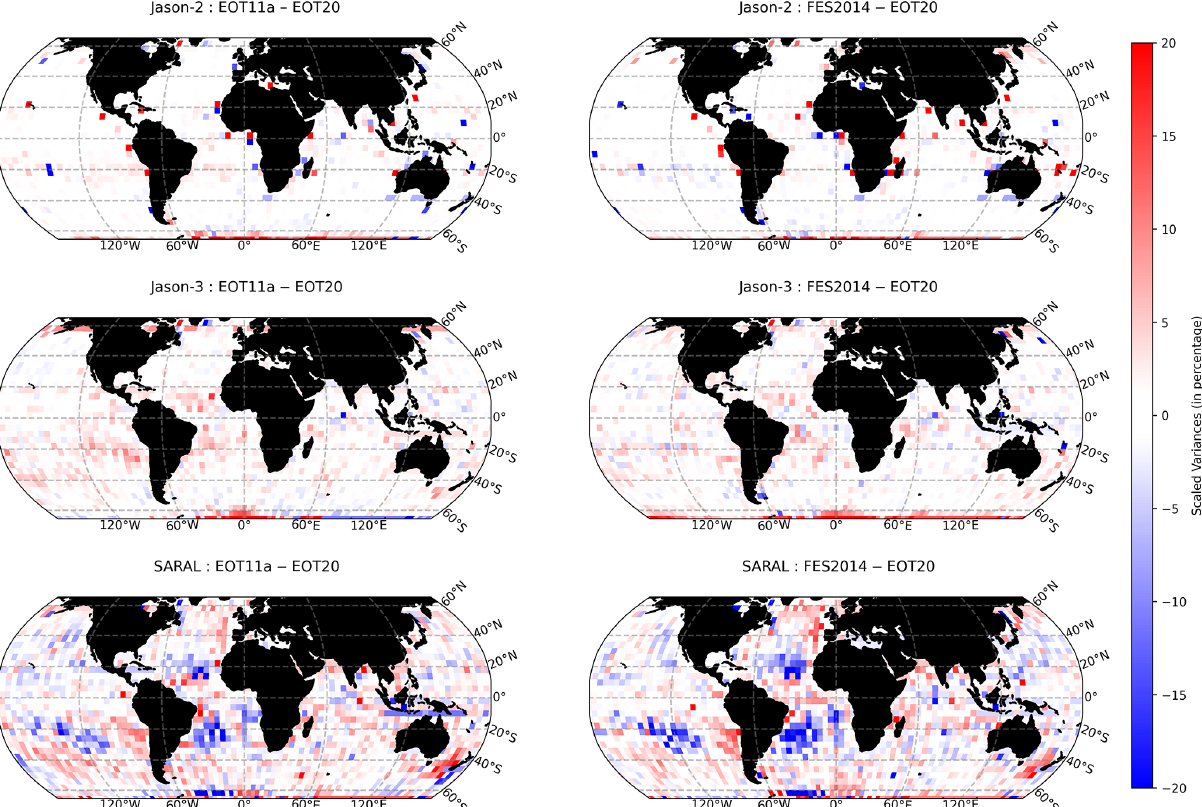
Figure 6. The global scaled SLA variances differences for Jason-2, Jason-3 and SARAL in percentages. The colour bar is chosen for ease of understanding with the variance differences scaled to highlight the differences between the results. The colours are chosen so that when there are regions of red colours EOT20 shows a lower variance, while when regions are blue the other tide model (EOT11a or FES2014) has a lower